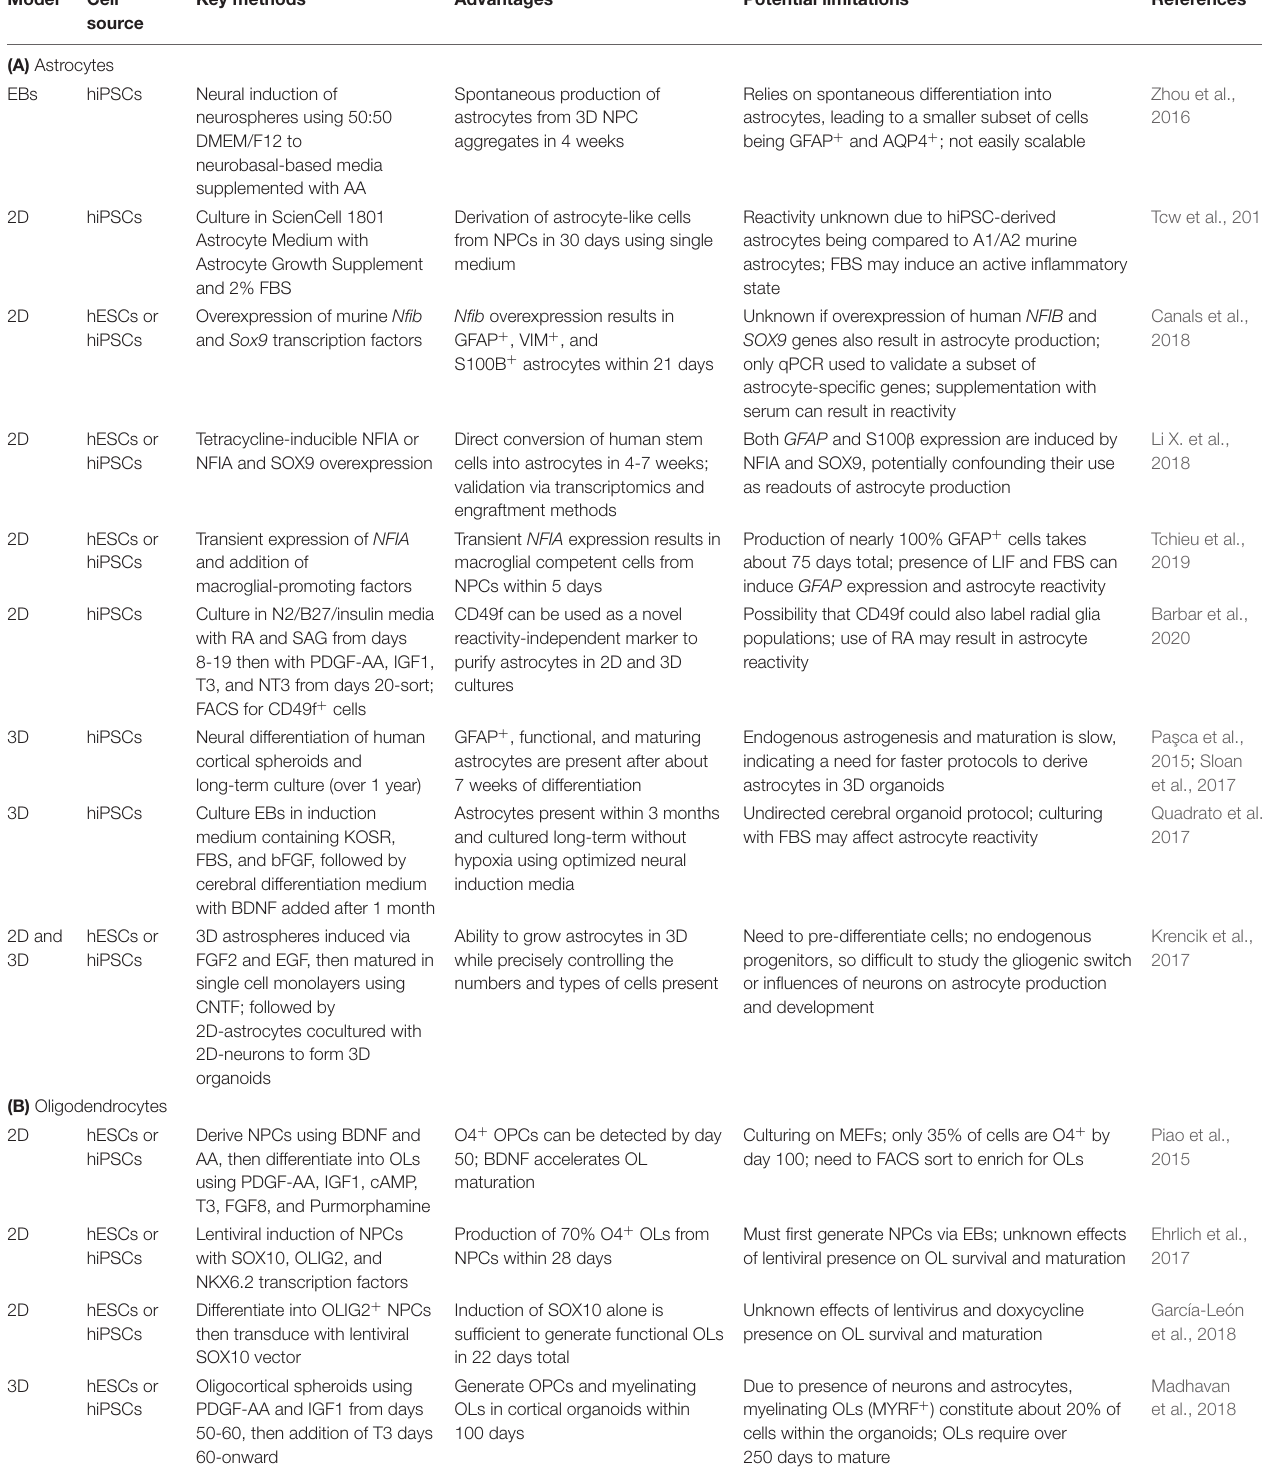
TABLE 2 | Recent advancements to 2D and 3D glial differentiation protocols